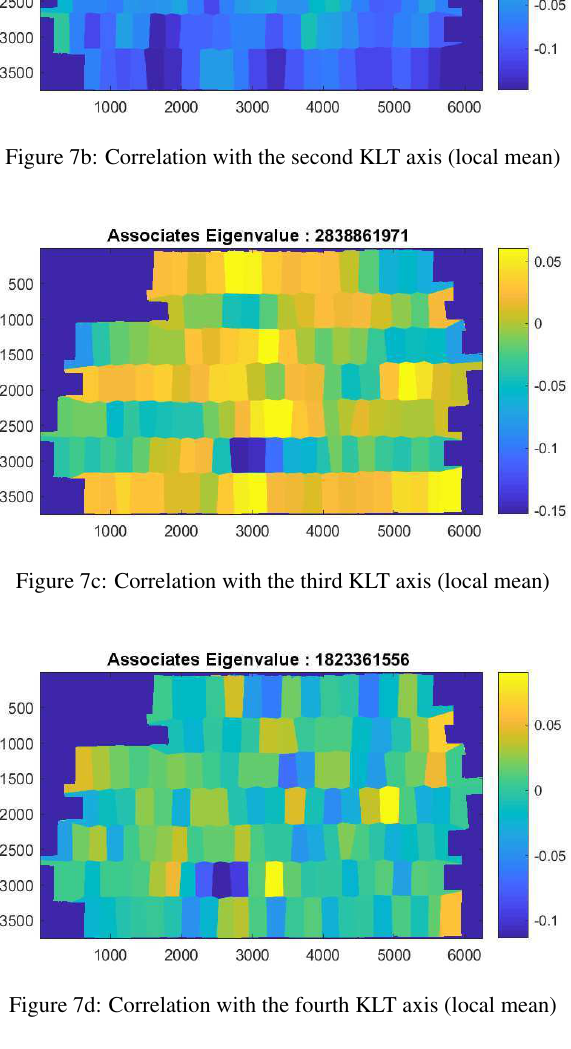
South of the mission. After considering the eigen image relative to the second axis, this could be interpreted as a change of